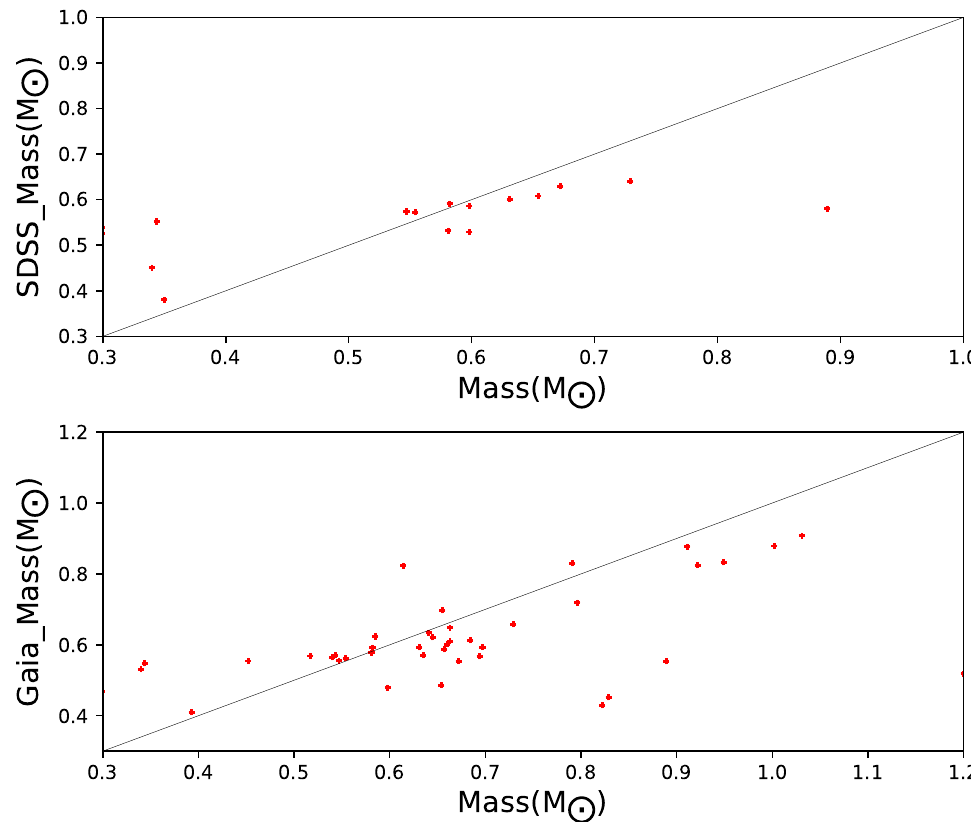
Figure 8. The mass we calculated compared to the mass calculated by Refs. [4,24]. The black solid lines are unit slope relationships. The red dots indicate the corresponding sample stars’